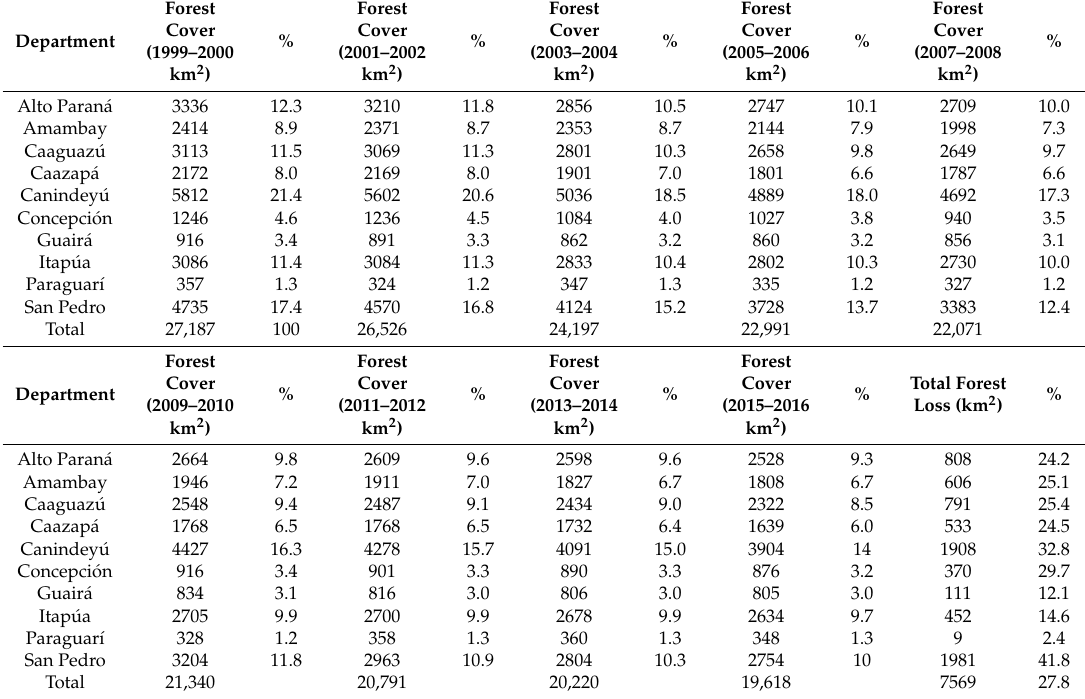
Table 3. Forest cover and forest cover loss in the BAAPA region from 1999 to